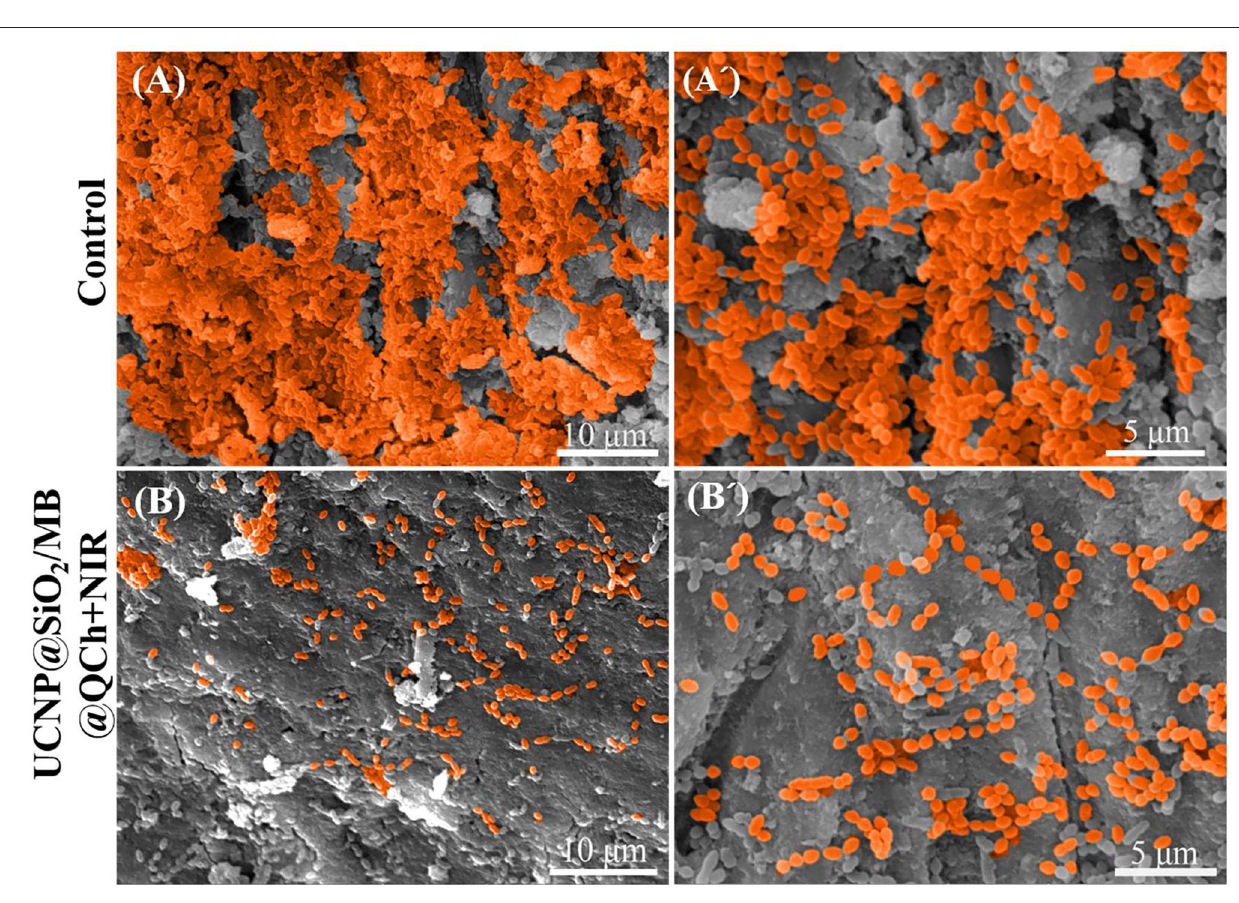
was remarkably higher than that of UCNP@SiO 2 /MB.